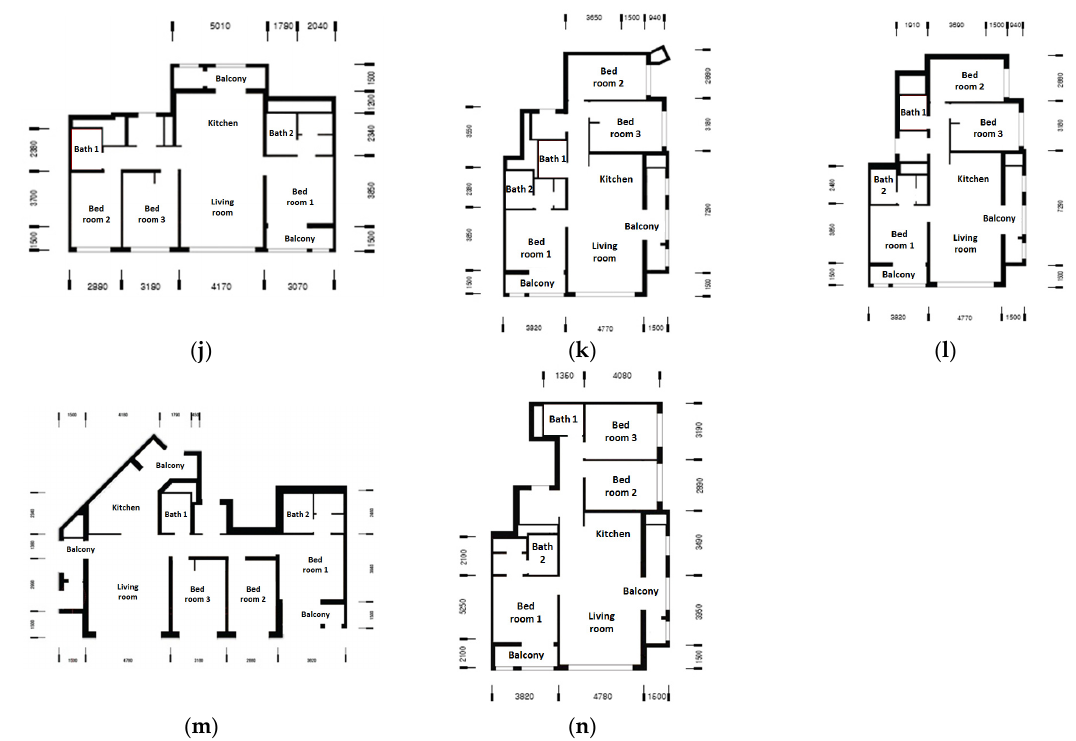
Figure 1. The 14 floor plans of the studied housing units with different floor areas: ( a ) 33 type; ( b ) 36 type; ( c ) 46 type; ( d ) 59A type; ( e ) 59B type; ( f ) 59C type; ( g ) 74A type; ( h ) 74B type; ( i ) 74C type; ( j ) 84A type; ( k ) 84B1 type; ( l ) 84B3 type; ( m ) 84C type; ( n ) 84D type.